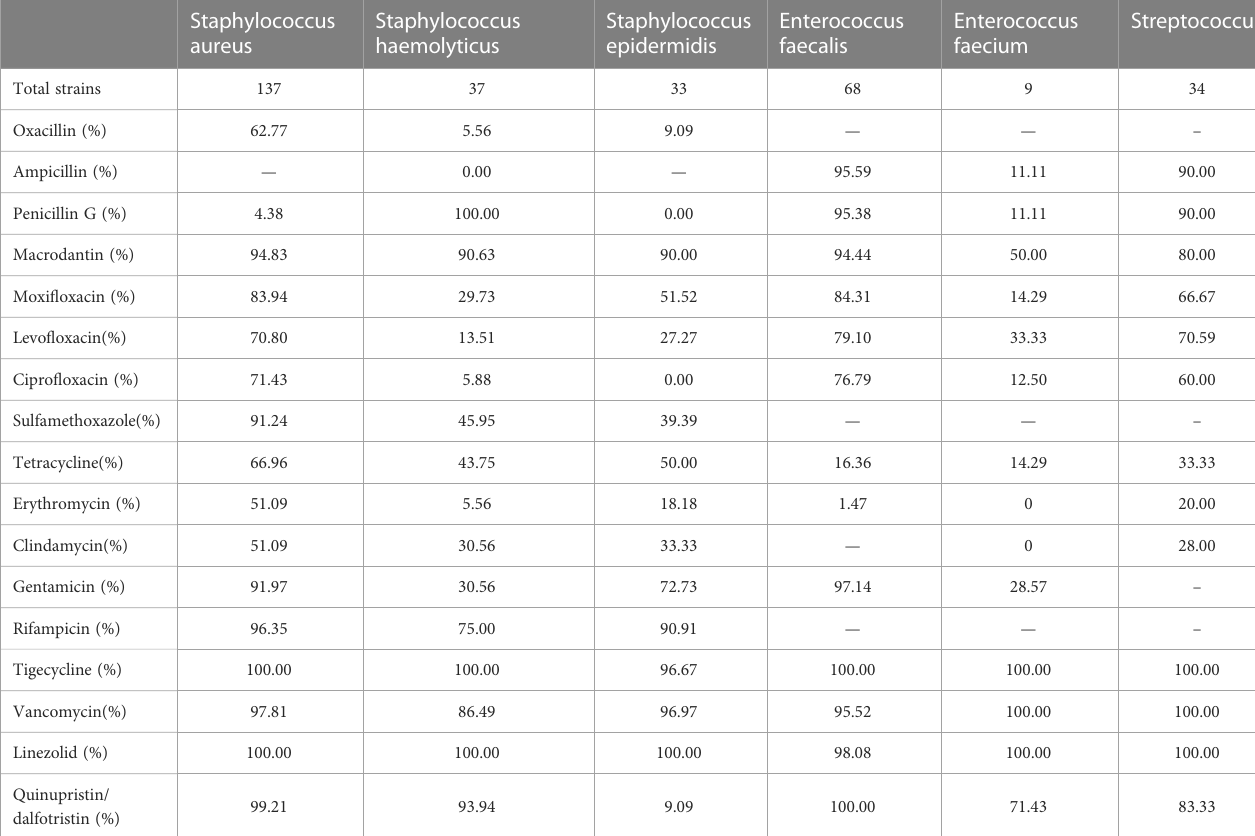
TABLE 3 Drug sensitivity results of gram-positive bacteria from diabetic foot